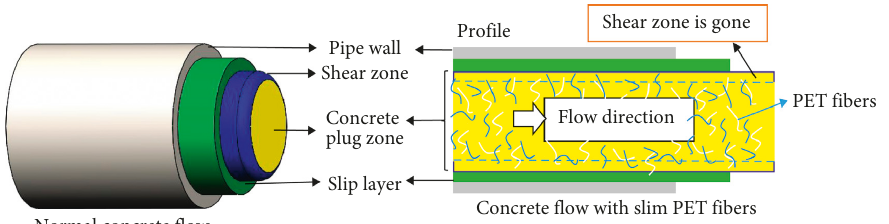
Figure 7: Changes of the flow forms of fresh concrete in pipes after mixing PET fibers.